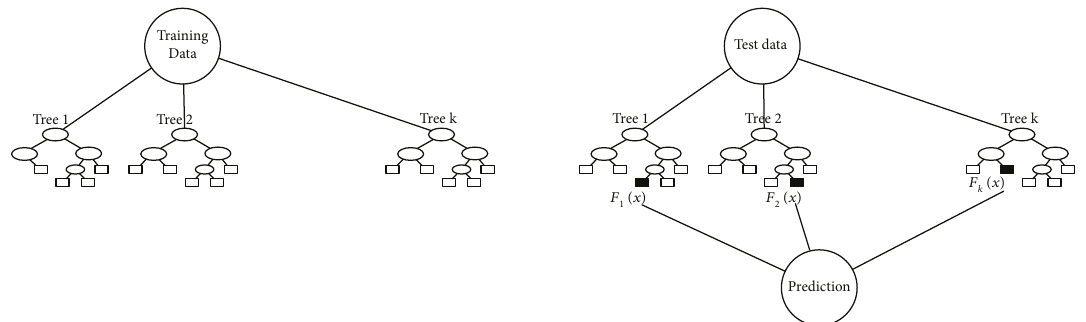
Figure 2: Regression tree ensemble: a typical random forest.